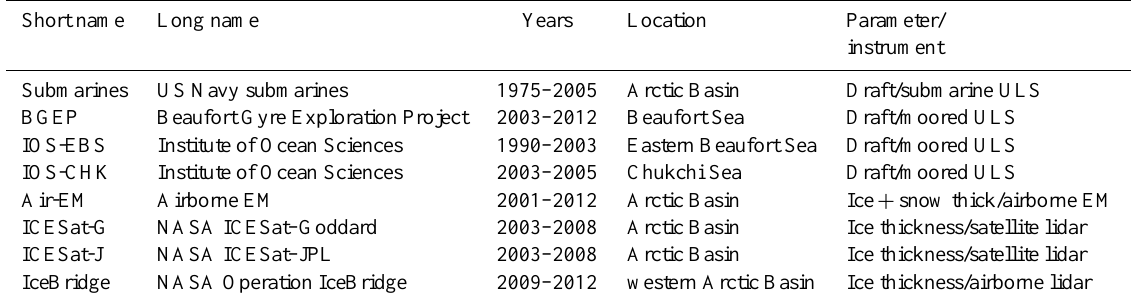
Table 1. Observational data